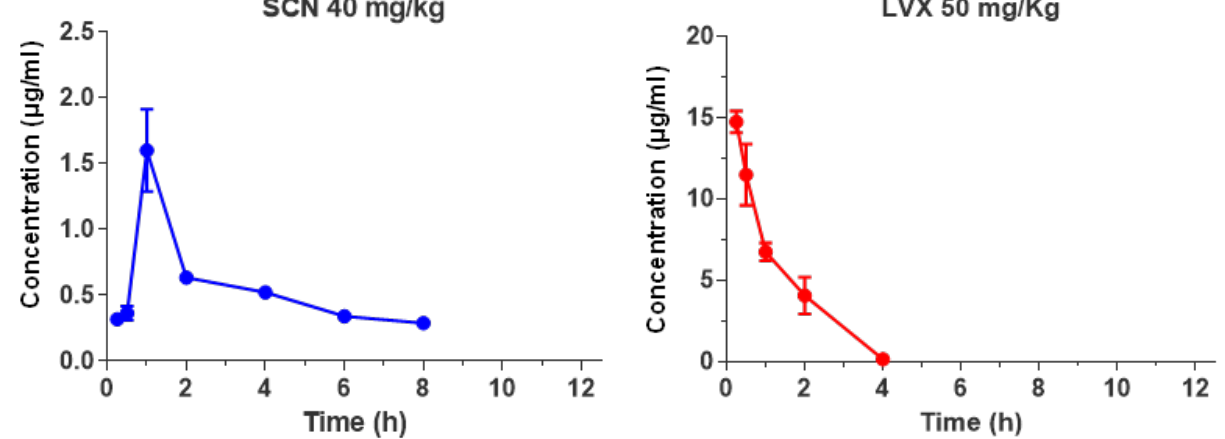
Figure 3. Serum drug concentrations ( µ g/mL) of SCN and LVX after single dose administration of 40 mg/kg or 50 mg/kg, respectively.